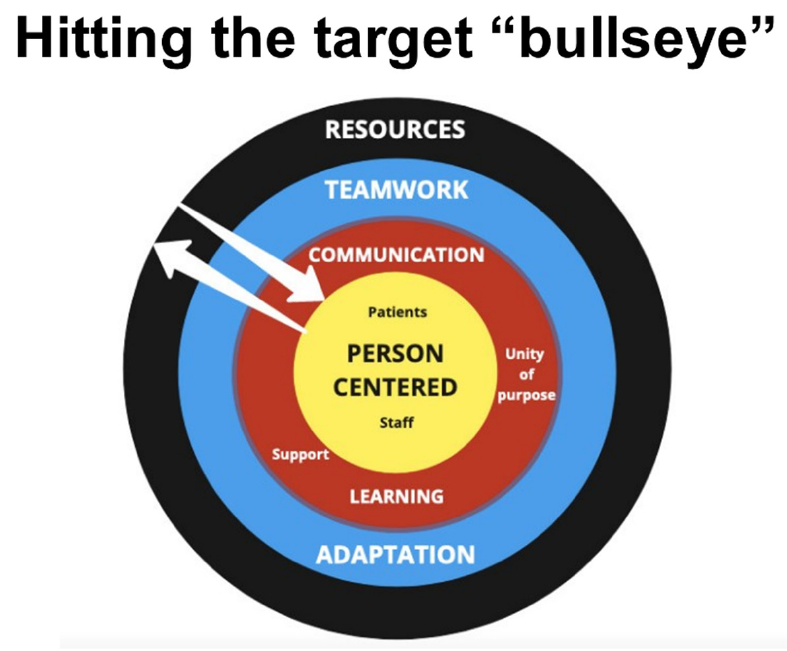
Figure 5. A diagrammatic representation of the main